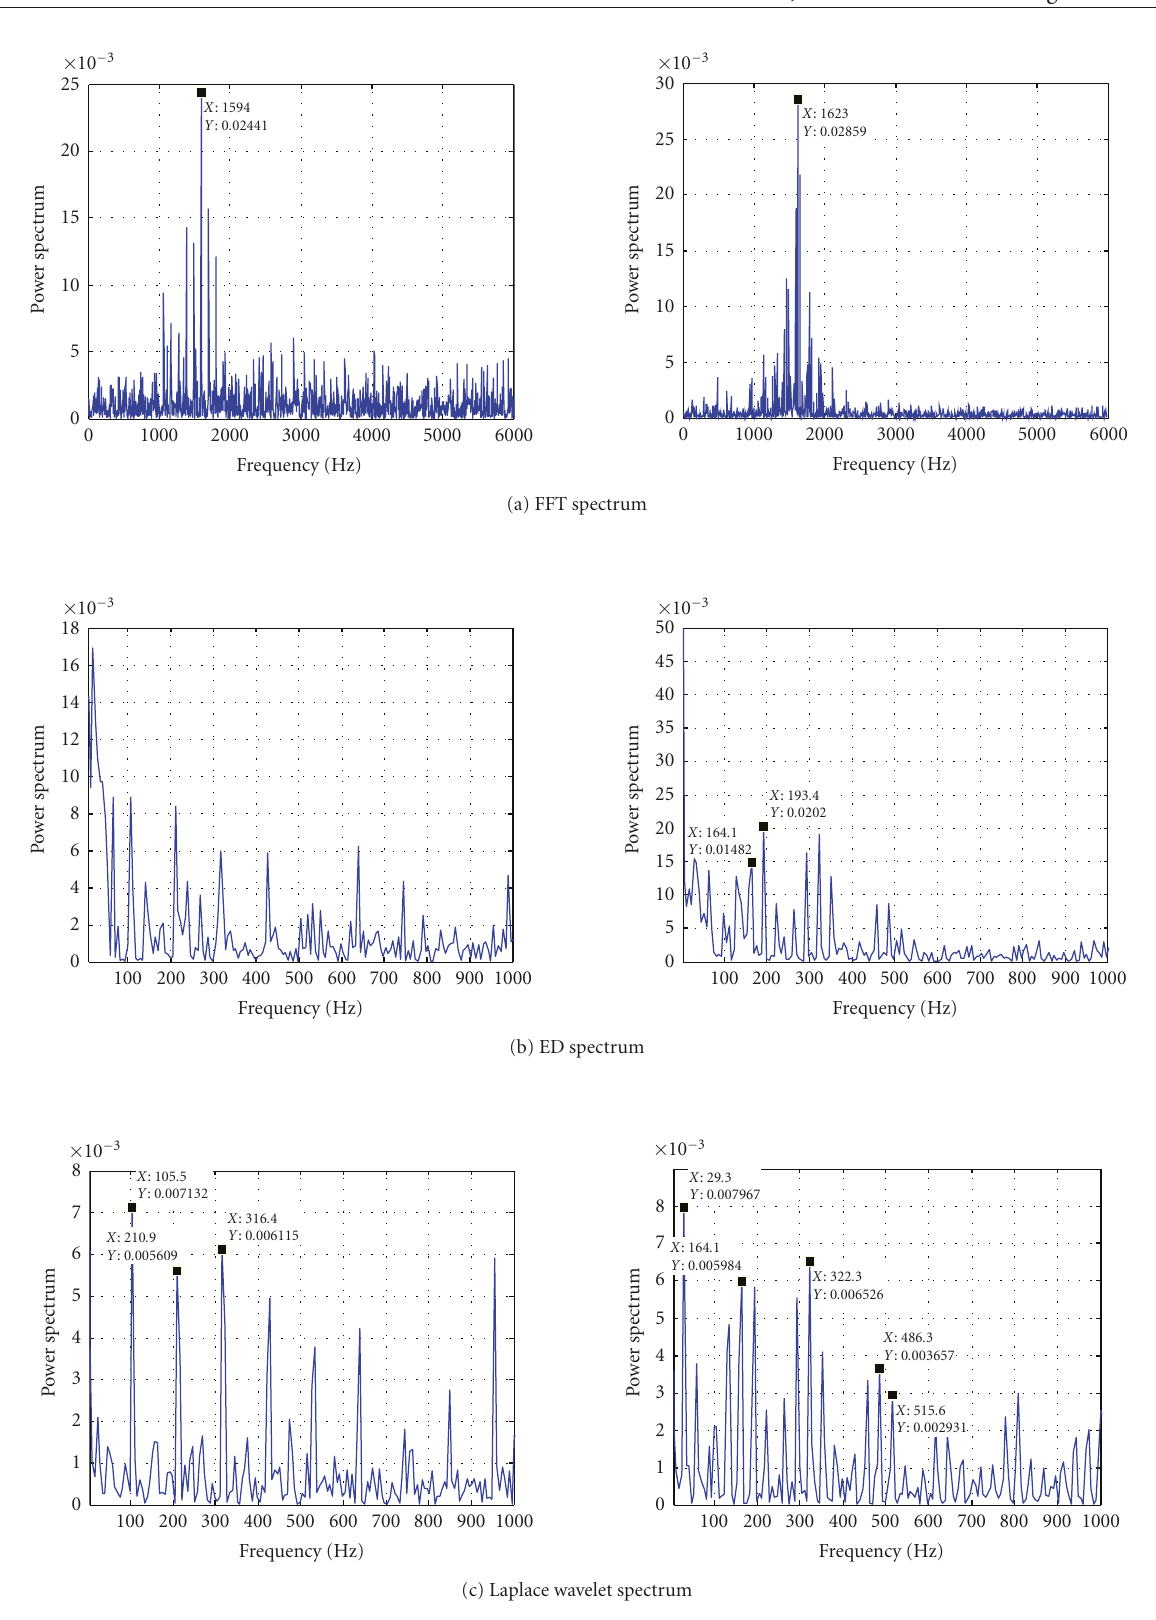
Figure 7: The simulated vibration signal power spectrum, the envelope power spectrum, and the Laplace-wavelet transform power spec- trum, respectively, for rolling bearing with (left column) outer-race fault and (right column) inner-race